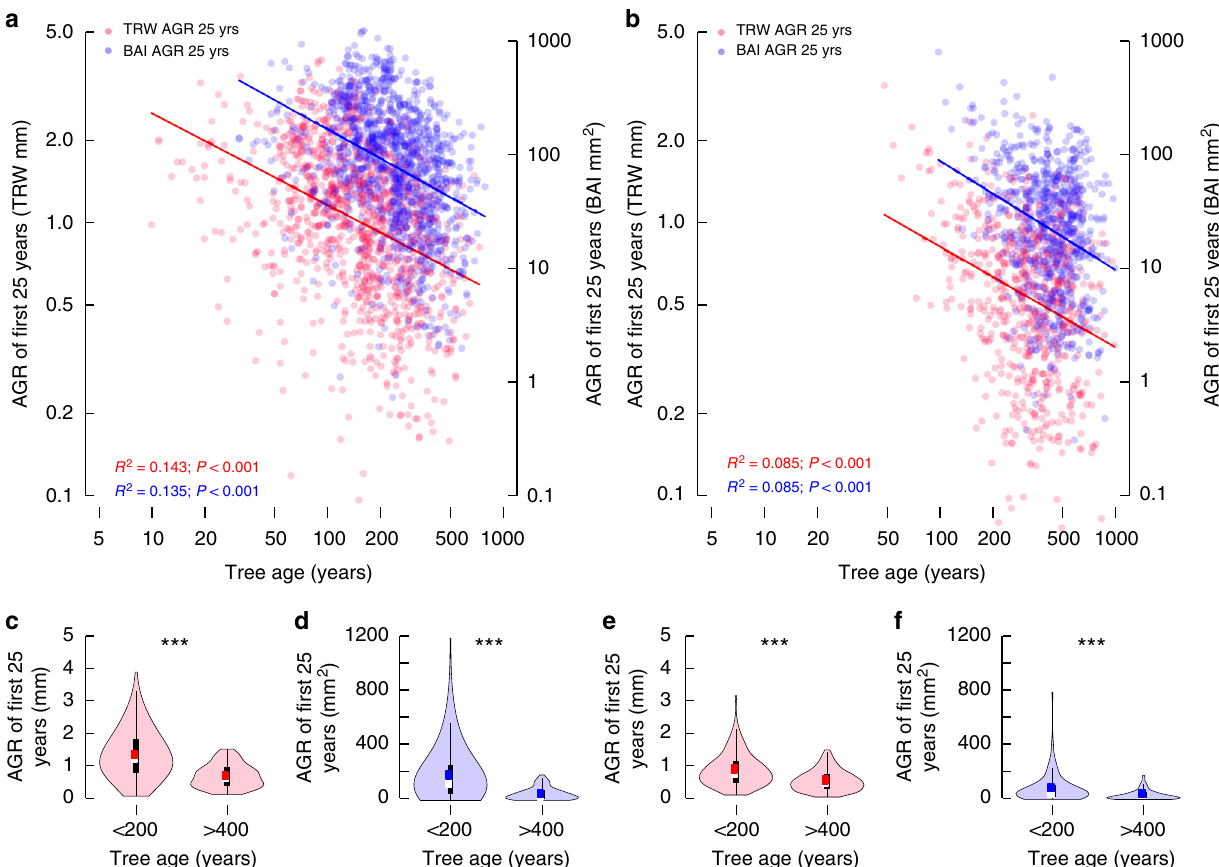
Fig. 3 Tree growth and lifespan. Scatter plots of annual tree-ring width (TRW; red symbols and lines) and basal area increment (BAI; blue symbols and lines) averaged over the fi rst 25 years of juvenile growth (AGR 25 yrs) in all living and relict tree stems from the Spanish Pyrenees ( a ) and Russian Altai ( b ). Each point represents one tree. Solid lines are linear models on log-transformed data, showing the tradeoff between tree growth and lifespan (productivity and longevity). Axes are log-scaled. Violin plots of annual tree-ring width (red) and basal area increment (blue) averaged over the fi rst 25 years of juvenile growth in trees aged ≤ 200 and ≥ 400 years from the Pyrenees ( c , d ) and Altai ( e , f ). Violin plots show the full distribution of data, with white dots referring to the median, and colored dots describing mean tree-ring width (red) and basal area increment (blue). The extent of the black lines in the violins represents the interquartile ranges, and the light bars show the 95% con fi dence intervals. Asterisks indicate signi fi cant differences between the two age classes (Mann – Whitney U Test; *** p < 0.001). Source data are provided as Source Data fi